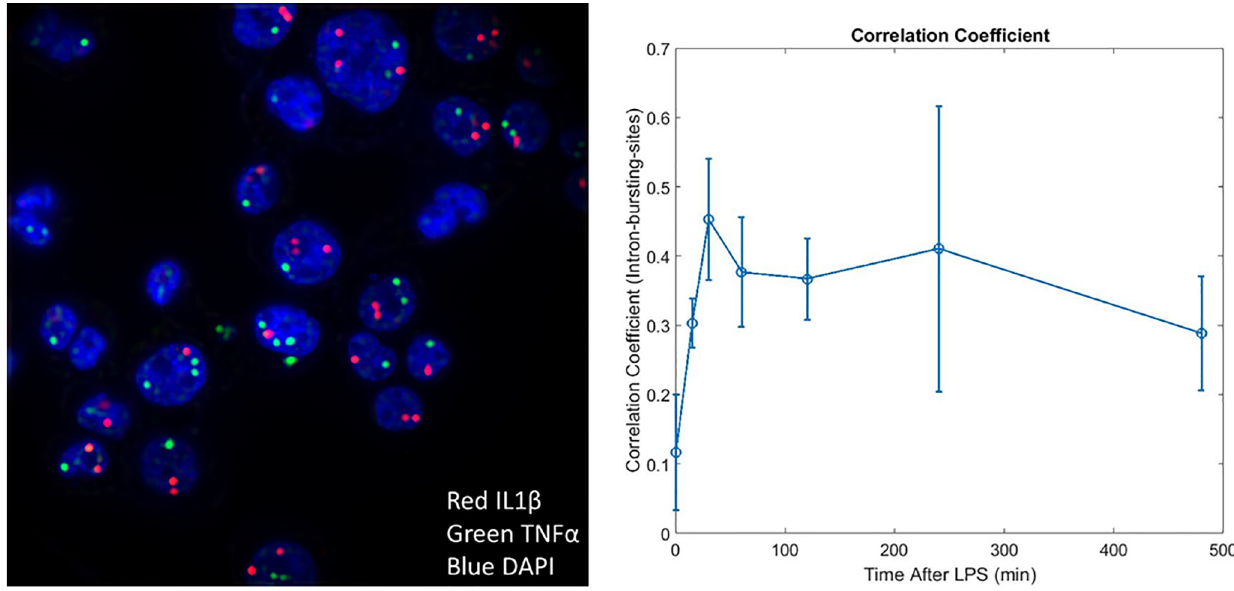
Fig 7. Correlation of intron bursting sites. The correlation peaks at 30 minutes when gene transcription is highly active. We note that this peak in correlation occurs earlier than the mRNA correlations. (Filtered intron image, raw data shown in S10 Fig).